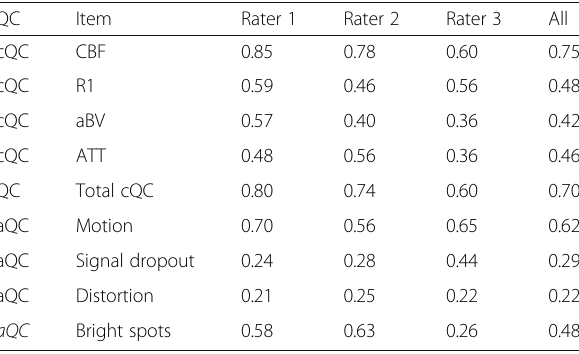
Table 2 Spearman ’ s correlation coefficient between the first (QC) and second (items) columns for raters individually (columns 3,4 and 5) and for all raters in the last column QC